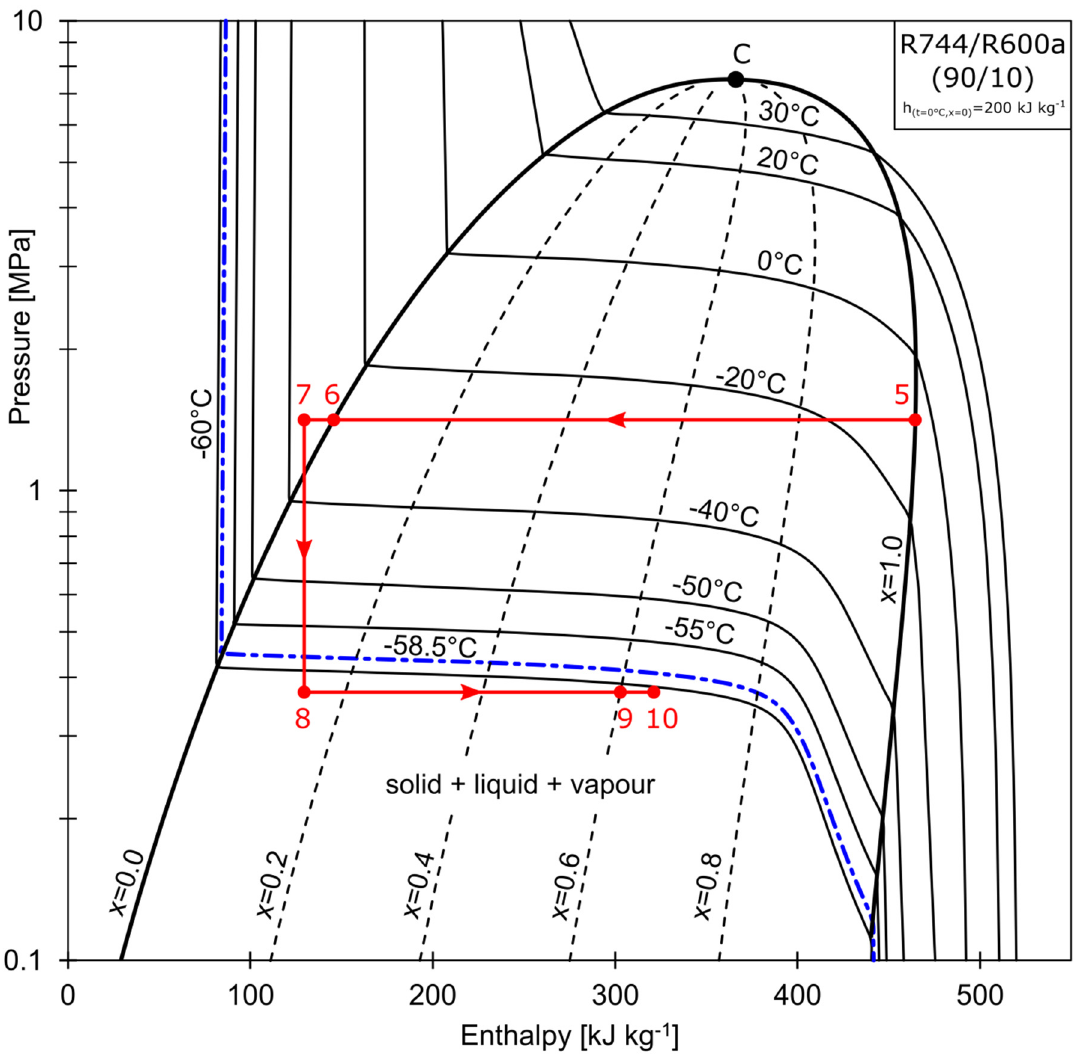
Figure 3. Phase changes of high CO 2 concentration mass flow.